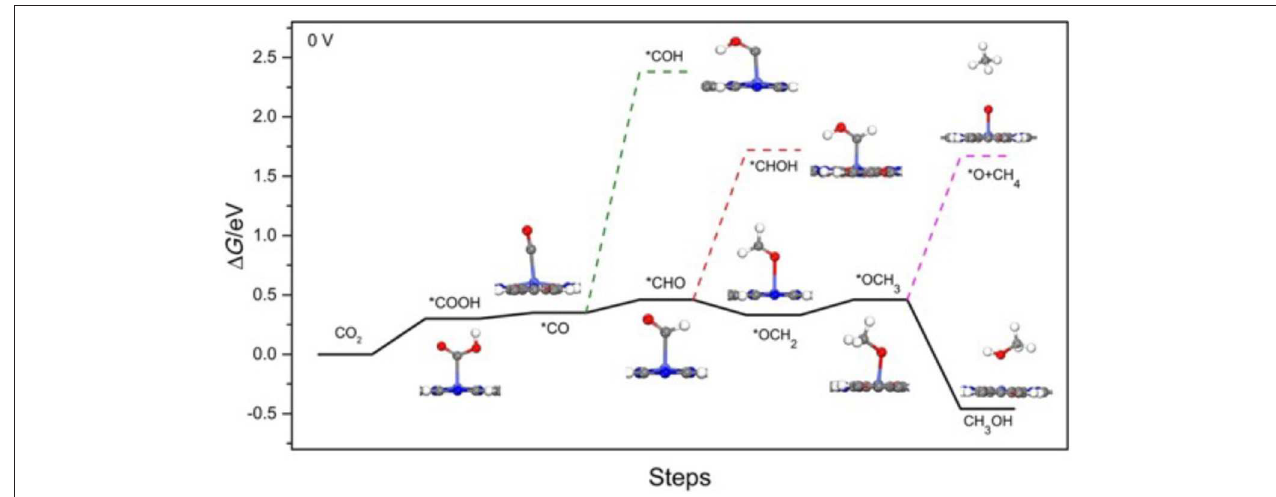
FIGURE 18 | (Solid line) Depiction of thermodynamically favored reaction pathways from CO 2 to CO and to CH 3 OH as calculated by Yao et al. (2018) (Dashed line) depicts the competing pathways. Reprinted with permission © 2018 Wiley VCH.